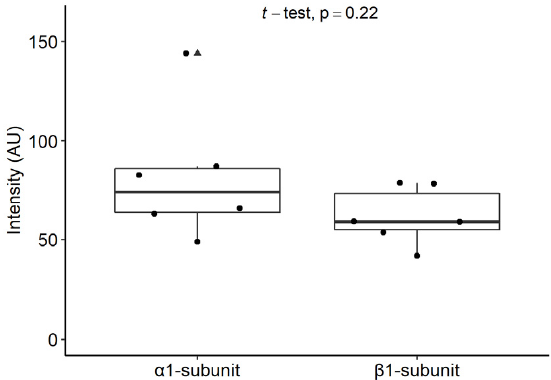
Figure 5. Staining intensities of the α 1 and β 1 subunits of sGC in the mast cells of inflamed human dental pulp. Note that there was no significant difference between the staining intensities of the α 1 and β 1 subunits of sGC in mast cells ( p = 0.22). Box and whisker plot shows maximum (upper vertical line), minimum (lower vertical line), median (horizontal line), and interquartile range (box). Dots are single measurements and triangles are outliers. A p -value < 0.05 was considered as significant.